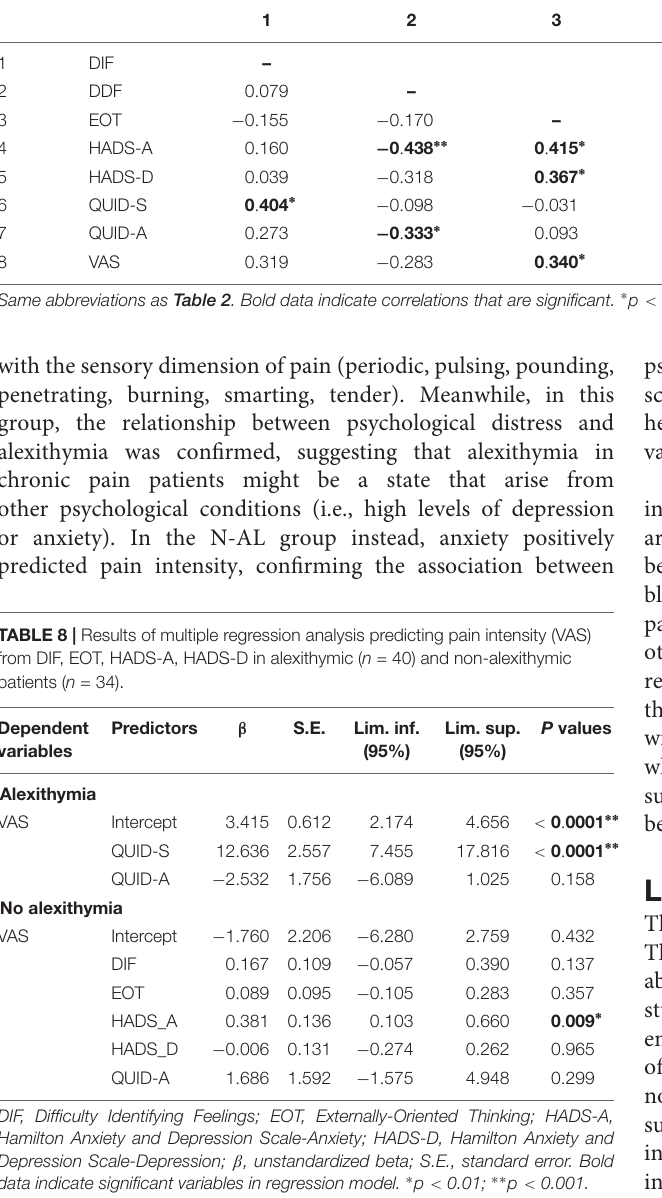
TABLE 7 | Significant Pearson correlation coefficients r: associations between alexithymia, psychological distress and pain in non-alexithymic patients ( n = 34).